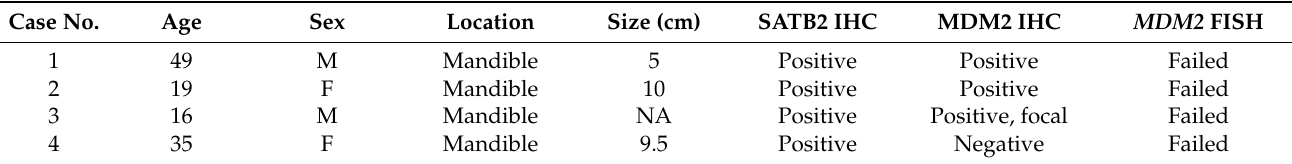
Table 1. Clinicopathologic features of osteosarcomas of the